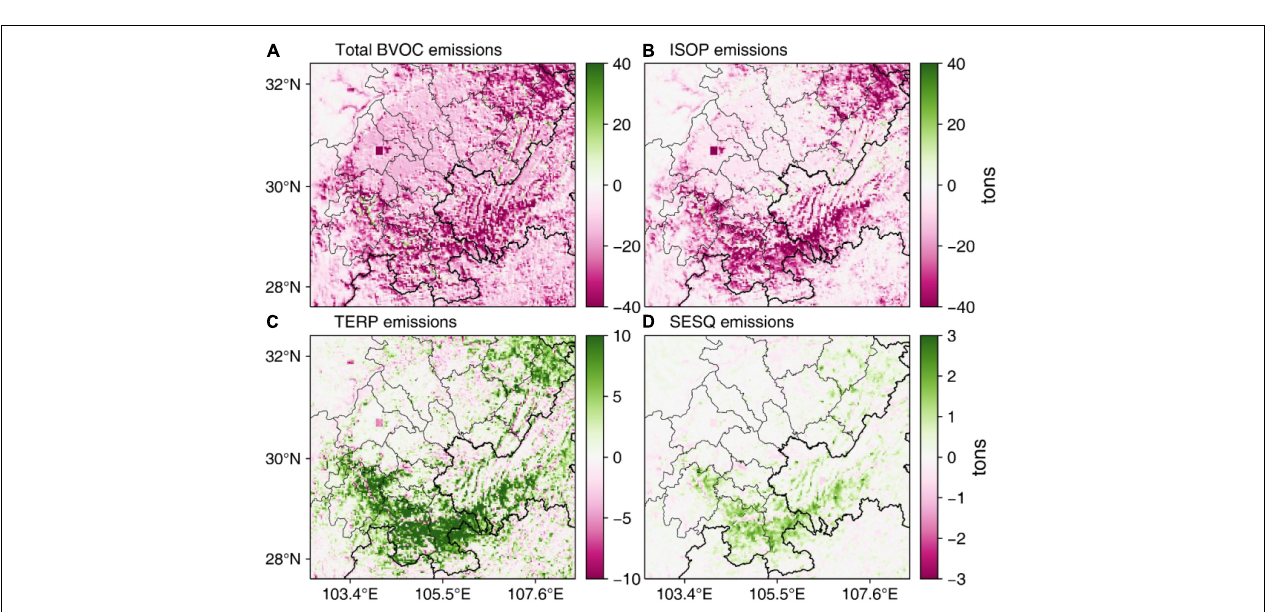
FIGURE 4 | Differences of annual total BVOC, isoprene, monoterpene, and sesquiterpenes emissions between the MEGAN2.1 and MEGAN3.1.